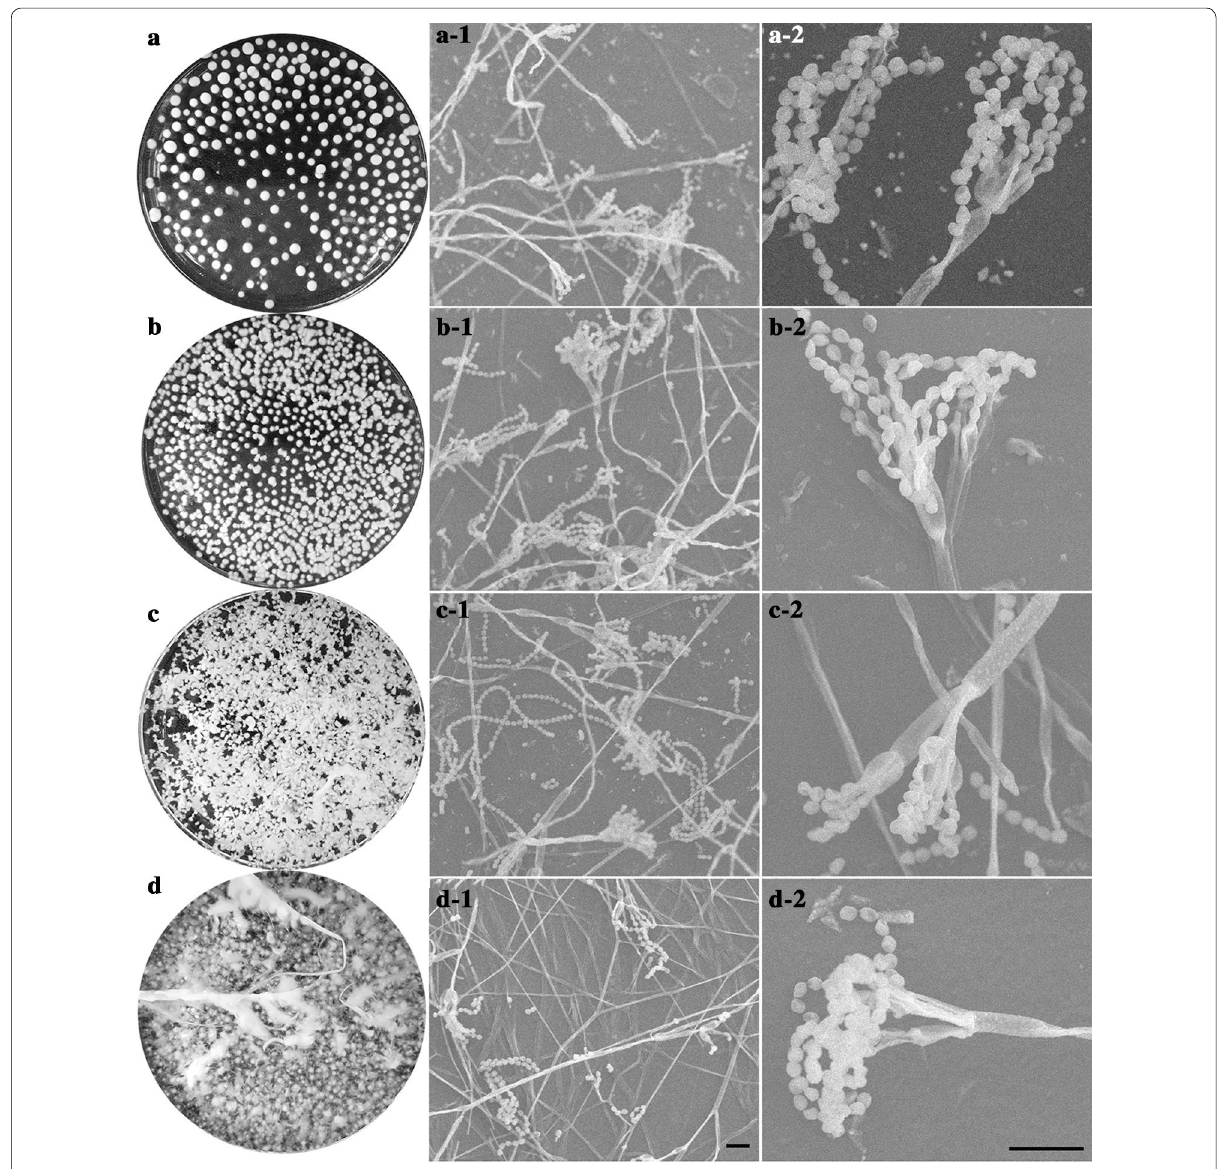
Fig. 3 Effects of different concentrations of Y 3 + on the morphology of Penicillium sp. ZD28. a – d are the mycelium pellet morphologies of Penicillium sp. ZD28 under the culture conditions with different concentrations of Y 3 + for 3 days. a - 1 / 2 , b - 1 / 2 , c - 1 / 2 and d - 1 / 2 denote micromorphologies of Penicillium sp. ZD28 cultured with different concentrations of Y 3 + , scale bar 10 μm. The concentrations of Y 3 + added according to the a / ‑1 / ‑2 , b / ‑1 / ‑2 , c / ‑1 / ‑2 , d / ‑1 / ‑2 , were 0, 73.71, 461.57, 580.67 μM